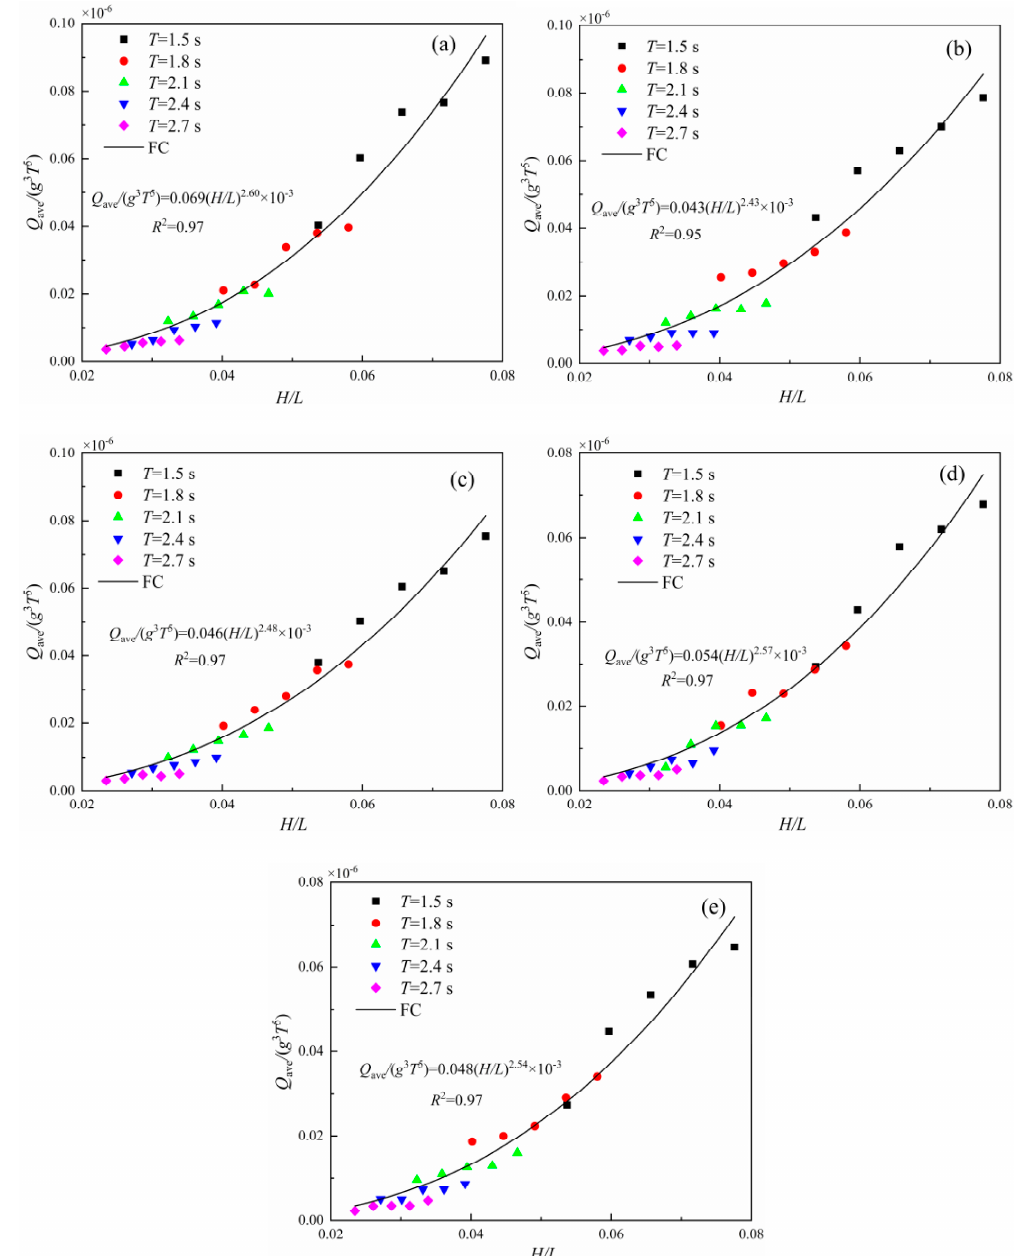
Figure 6. Q ave / g 3 T 5 relationship with H / L . ( a ) h = 0.1 m; ( b ) h = 0.2 m; ( c ) h = 0.3 m; ( d ) h = 0.4 m; ( e ) h = 0.5 m.